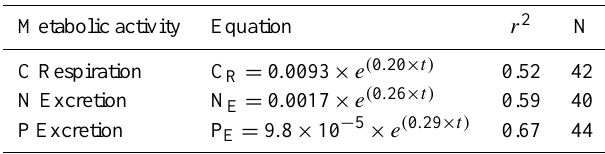
Table 4. Exponential equations relating temperature in ◦ C ( t ) with C respiration (C R ) and NH 4 -N (N E ) and PO 4 -P (P E ) excretion rates.